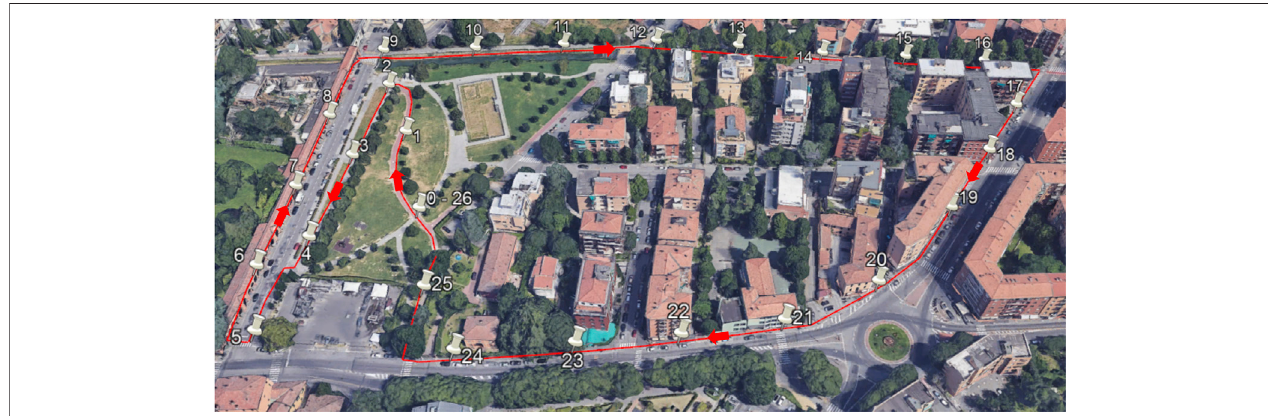
FIGURE 3 | Image taken from Google Earth showing the 1300-m path (red line) and the start and end points of each walking tract (white pins). Description of the tracts:1 – 5park(opensky),6 – 9arcades(totallyobstructedvisibility), 10 – 12bicycle lane(openskywithafewtrees), 13 – 17bicycle laneundertalltrees,withtallbuildings on both side (highly obstructed visibility), 18 – 24 sidewalk with tall buildings (partially obstructed visibility), and 25 – 26 park (open sky with a few trees).